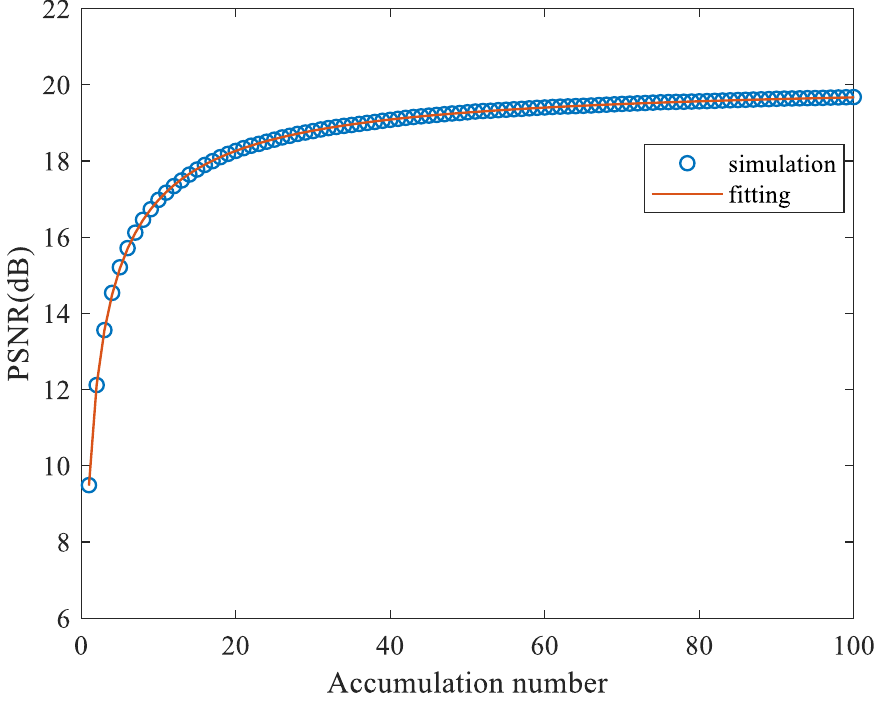
Figure 4. PSNR of the reconstructed image by MIFA binary CGHs (iteration number is 5) as a function of accumulation number. The values of the parameters ( S , K ) of the fitting curve are (3.11, 11.40).